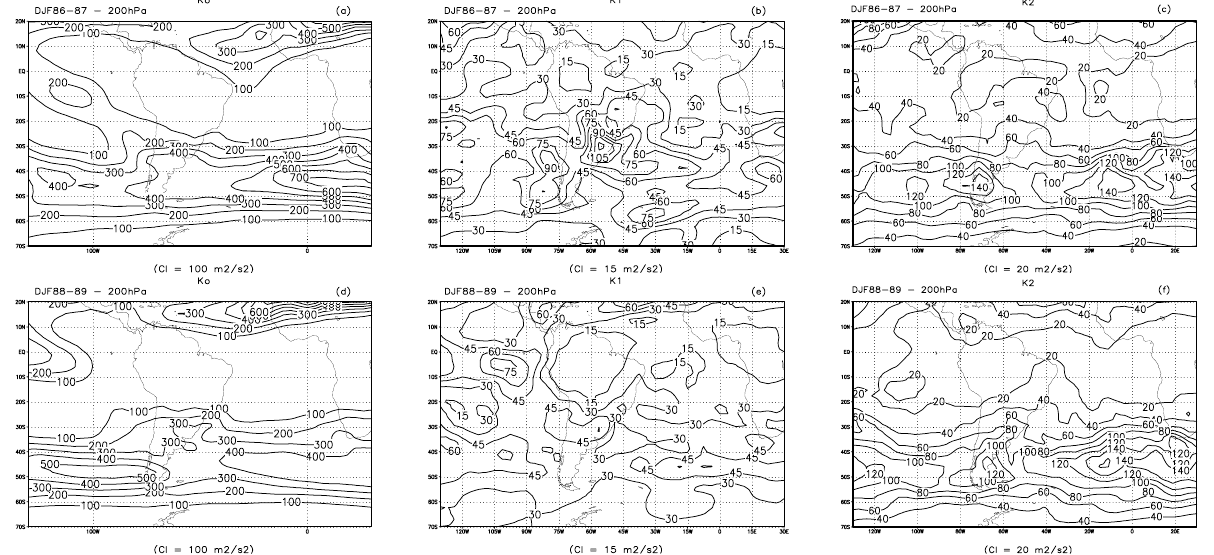
Fig. 5. Distribution of the episodal average kinetic energy at 200 hPa of the seasonal (left panels), intraseasonal (middle panels) and high frequency (right panels) components, in summers of 1986–1987 and 1988–1989, respectively. The values are expressed in m 2 s − 2 . CI stands for contour